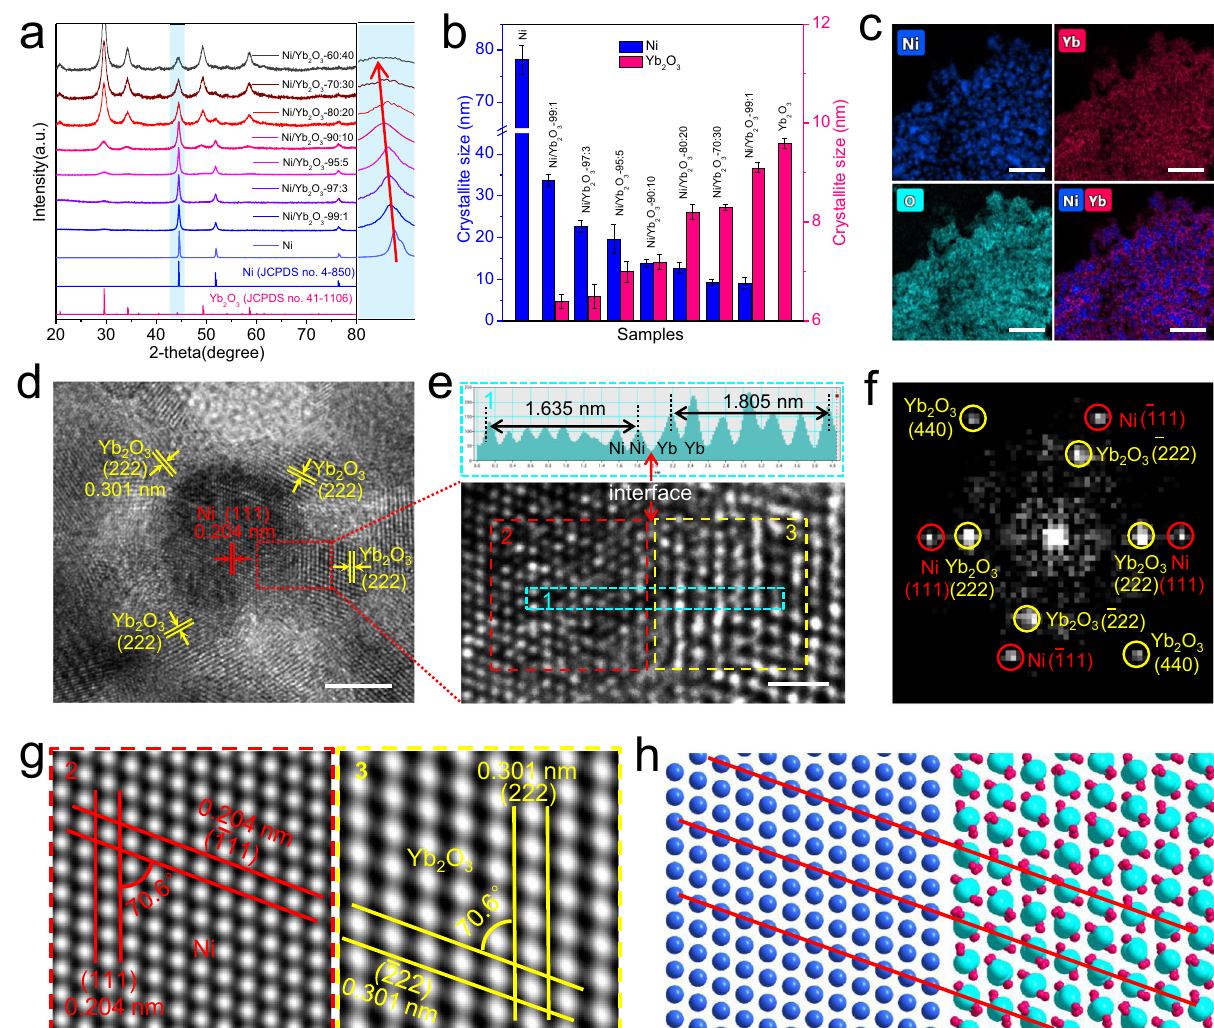
Fig. 3 Structural characterizations of Ni/Yb 2 O 3 . a XRD patterns of Ni and Ni/Yb 2 O 3 hybrids with various Ni:Yb molar ratios. b Crystallite sizes derived from XRD patterns with the Debye – Scherrer equation. The error bars show the standard derivation based on triplicate measurements. c Elemental mapping of Ni/Yb 2 O 3 (scale bar: 100 nm). d , e HRTEM images of Ni/Yb 2 O 3 (scale bar: 5 nm for d and 1 nm for e ), and line scan of HRETM image. f Fast Fourier transform (FFT) pattern from ( e ). g Inverse FFT patterns corresponding to the regions of 2 and 3 in ( e ). h Schematic diagram of the structures corresponding to the regions of 2 and 3 in ( e ). The blue, magenta, and cyan spheres represent the Ni, O, and Yb atoms,